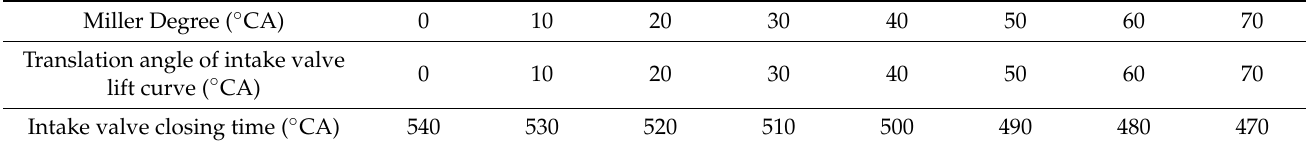
Table 1. Early closing of inlet valve in two schemes.